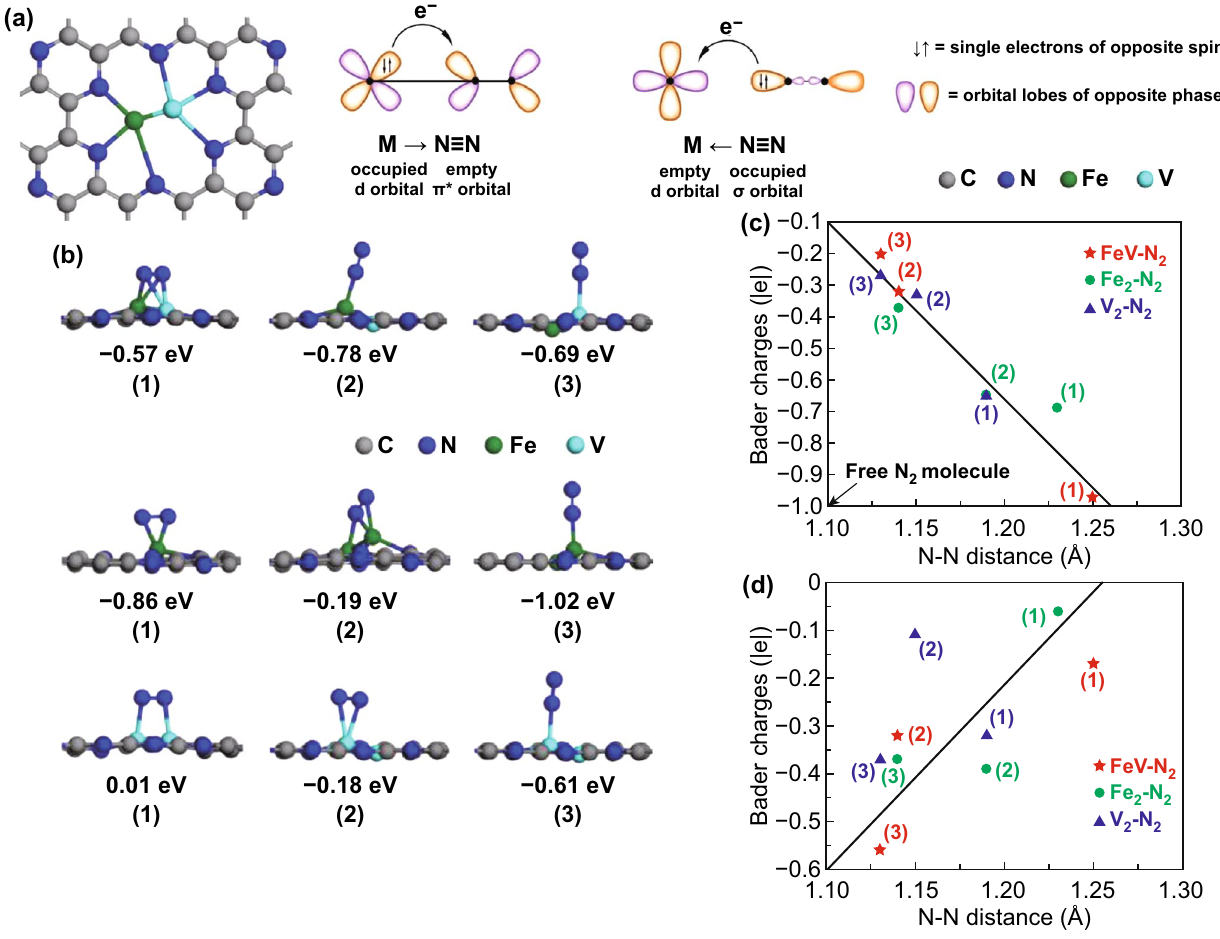
Fig. 1 a Optimized structures of FeV anchored on C 2 N substrate and simplified schematic diagram of the bonding between the transition metal and N 2 . b Optimized structures and corresponding adsorption energies of N 2 adsorption on FeV@C 2 N, Fe 2 @C 2 N, and V 2 @C 2 N. c Relationship between Bader charges of adsorbed N 2 and N–N bond lengths. d Relationship between Bader charge difference of two adsorbed N atoms and N–N bond lengths [15]. Copyright 2020